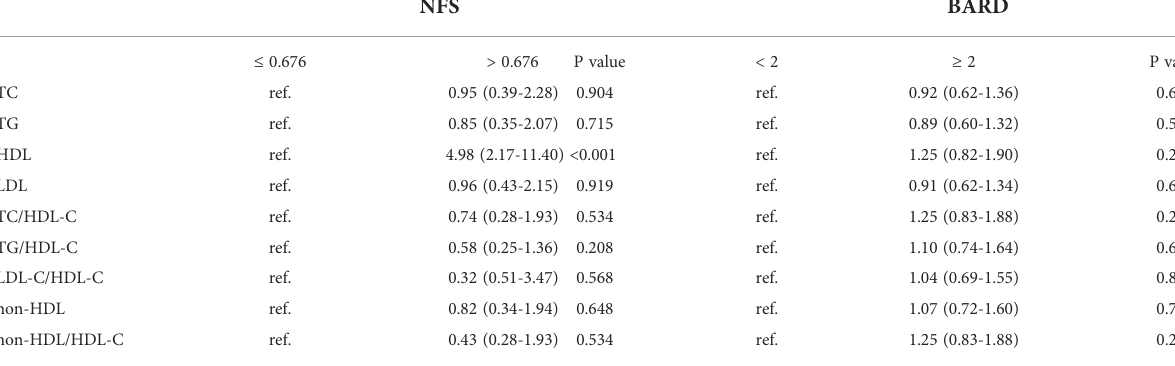
TABLE 5 Odds raitos and 95% con fi dence intervals of lipid parameters in terms of the quartiles for advanced liver fi brosis. NFS BARD ≤